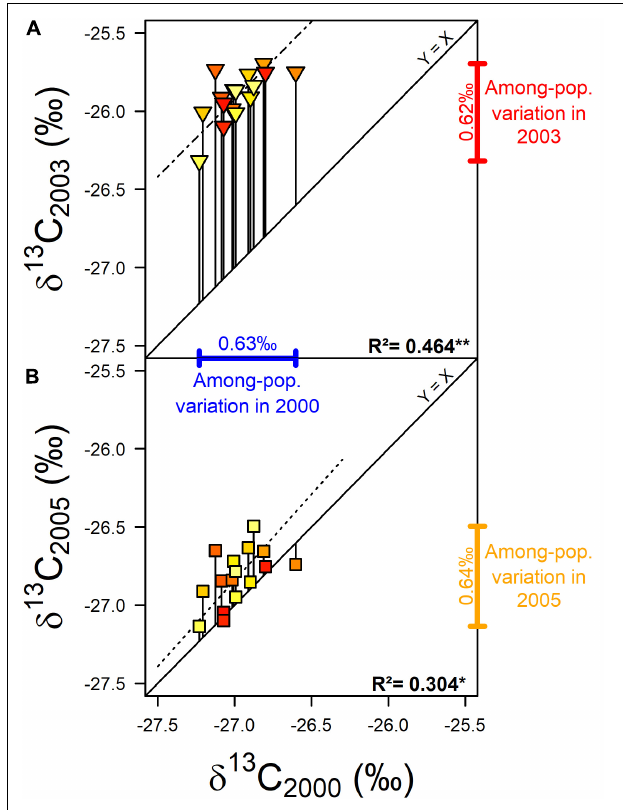
FIGURE 4 | Population δ 13 C in 2003 ( A ; severely dry year, triangles) and in 2005 ( B ; moderately dry year, squares) compared to δ 13 C in 2000 (wet year). The vertical lines between the Y = X line and each point represent the change of δ 13 C between dry and wet years ( δ 13 C plasticity index) for each population. Dotted lines are the type II regression lines between δ 13 C in 2003 and 2000 (A) and δ 13 C in 2005 and 2000 (B) . The corresponding coefficient of determination ( R 2 ; n = 16) and significance level (*: 0.01 < p < 0.05; **: 0.001 < p < 0.01) are also shown. Point colors indicate the average water deficit index (dimensionless) calculated over the 1960–1999 period in each provenance site (see Figure 1 and Supplementary Table 1